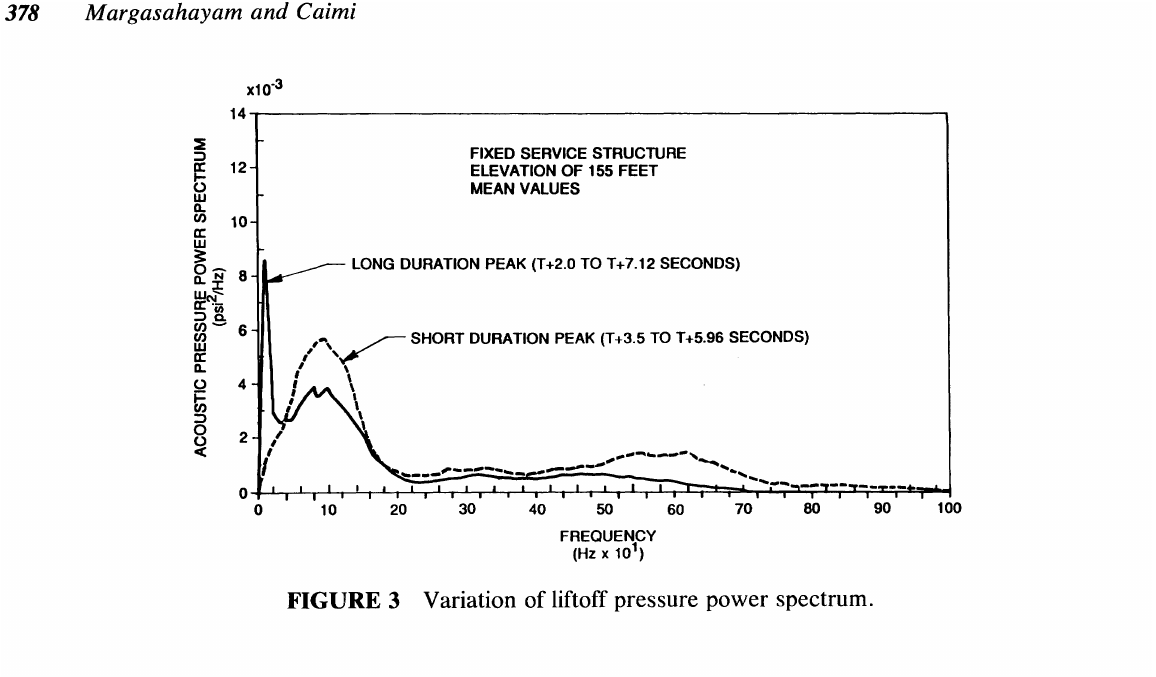
FIGURE 3 Variation of liftoff pressure power spectrum.